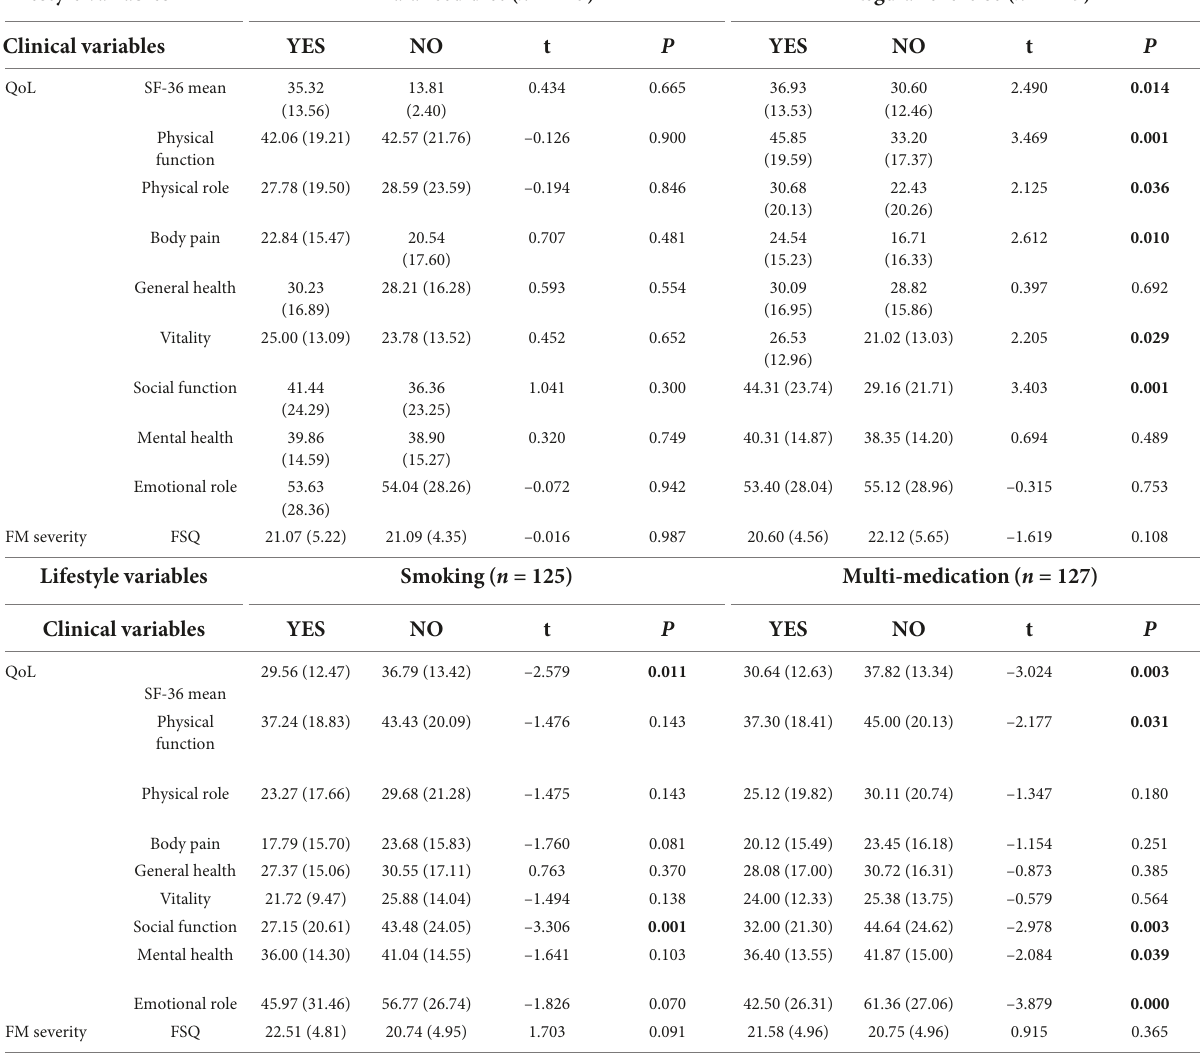
TABLE 4 Student’s t -test for independent samples comparing groups established by balanced diet, regular exercise, smoking and multi-medication in clinical variables (QoL and severity of FM). Lifestyle variables Balanced diet ( n = 125) Regular exercise ( n = 127) Clinical